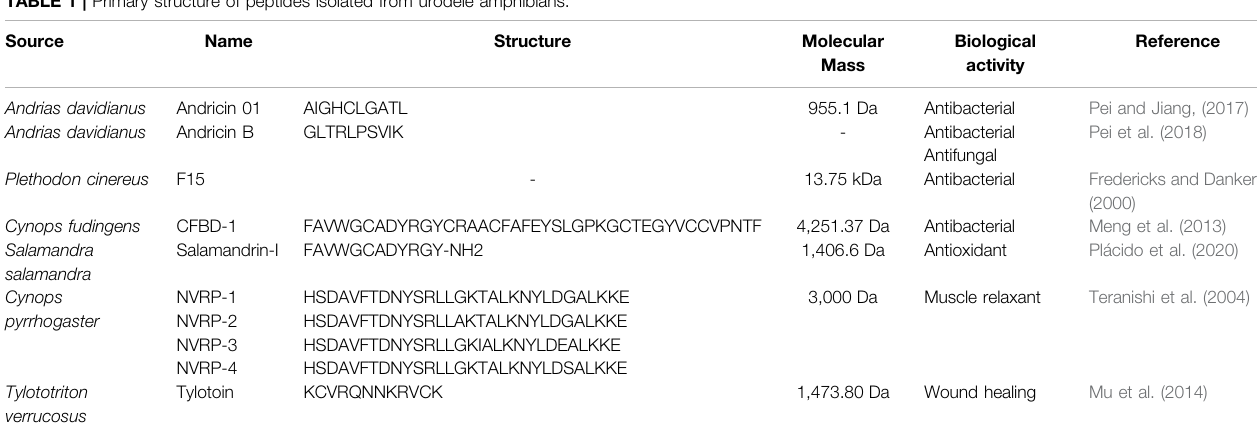
TABLE 1 | Primary structure of peptides isolated from urodele